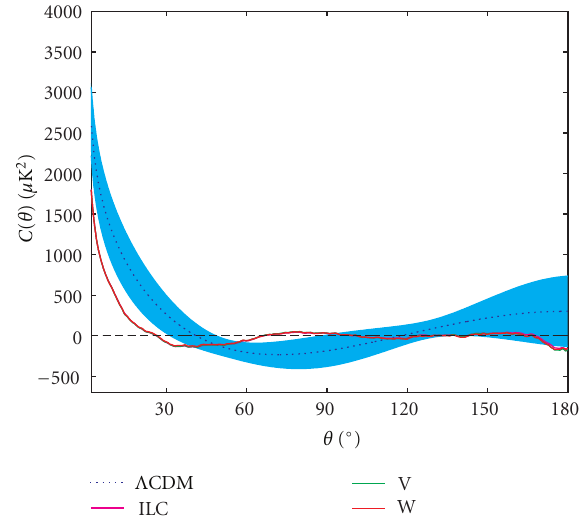
Figure 17: Angular correlation of CMB anisotropy: solid lines denote the angular correlation of WMAP data. Dotted line and shaded region denote the theoretical prediction and 1 σ ranges, as determined by Monte-Carlo simulations ( Λ